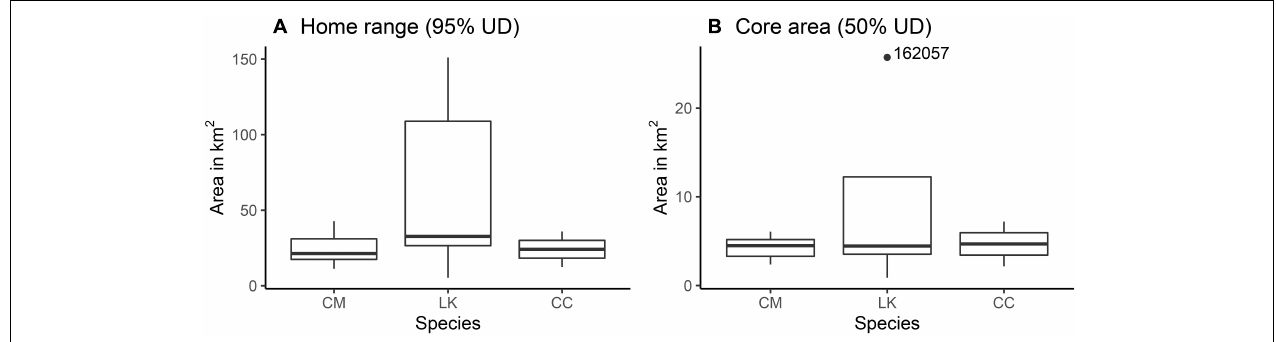
FIGURE 6 | Histograms of the proportion of time each species spent within each dive depth bin. Data were obtained from 13 turtles (7 CM green turtles; 4 LK Kemp’s ridley turtles; and 2 CC loggerhead turtles), tracked between July and September (2014–2017) in the Crystal River region, United States.